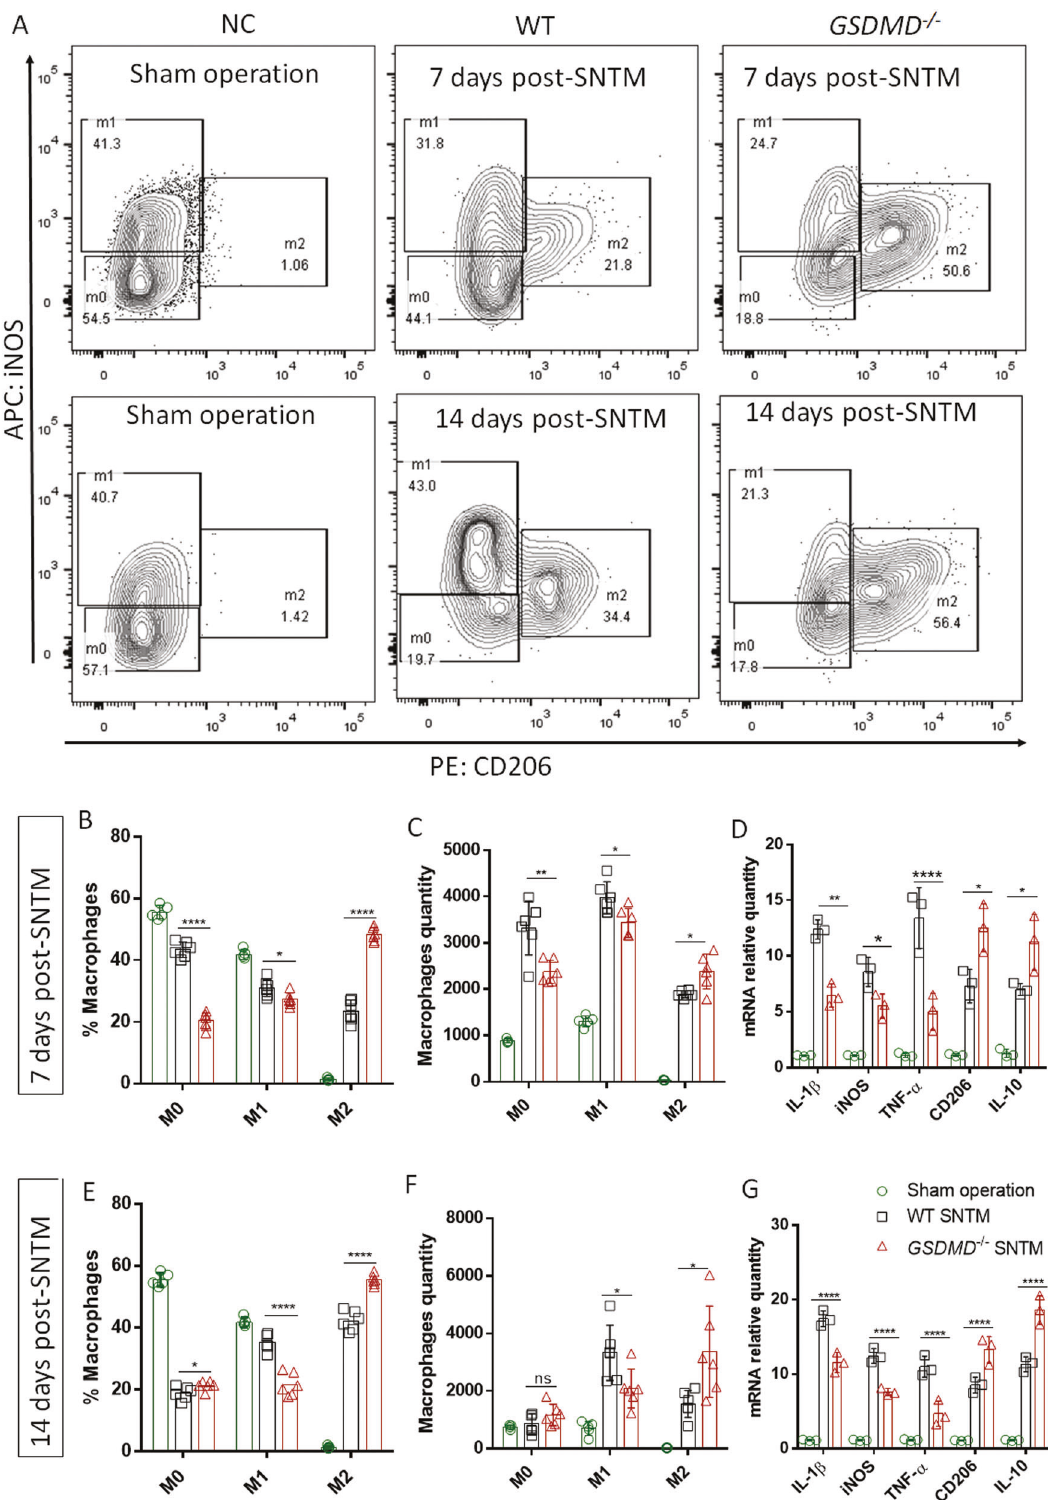
Fig. 4 GSDMD-mediated pyroptosis increased M1 polarization while hampering M2 polarization in the SNTM model. A Decreased M1 and increased M2 ratios were found on either the 7th or the 14th day post-operation. B , C The comparison of macrophage phenotypic ratios and quantities, respectively, on the 7th day (NC, n = 5; WT or GSDMD − / − , n = 6). D The WT SNTM bridges had higher IL-1 β and iNOS and lower CD206 and IL-10 mRNA expression than the GSDMD − / − SNTM bridges on the 7th day post-operation ( n = 3). E , F Comparison of macrophage phenotypic ratios and quantities on the 14th day, respectively (NC, n = 5; WT or GSDMD − / − , n = 6). G The WT SNTM bridges had higher IL-1 β and iNOS and lower CD206 and IL-10 mRNA expression than those of the GSDMD − / − group on the 14th day post-operation ( n = 3). * p < 0.05; ** p < 0.01; *** p < 0.001; **** p <